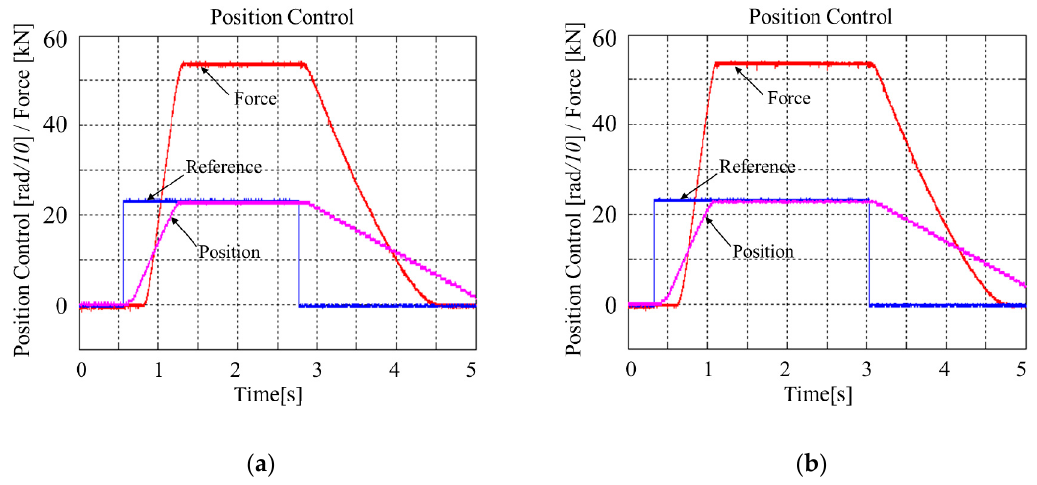
Figure 17. Experimental result of position control: ( a ) without MTPA and ( b ) with MTPA.